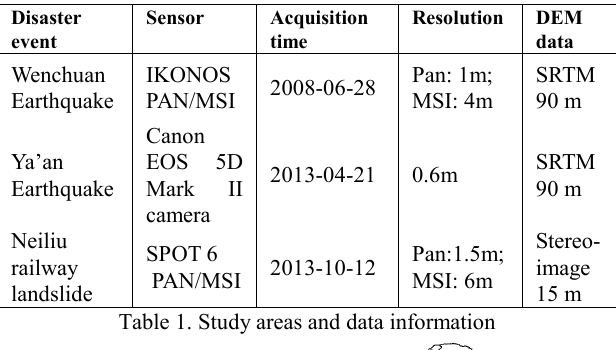
Table 1. Study areas and data information